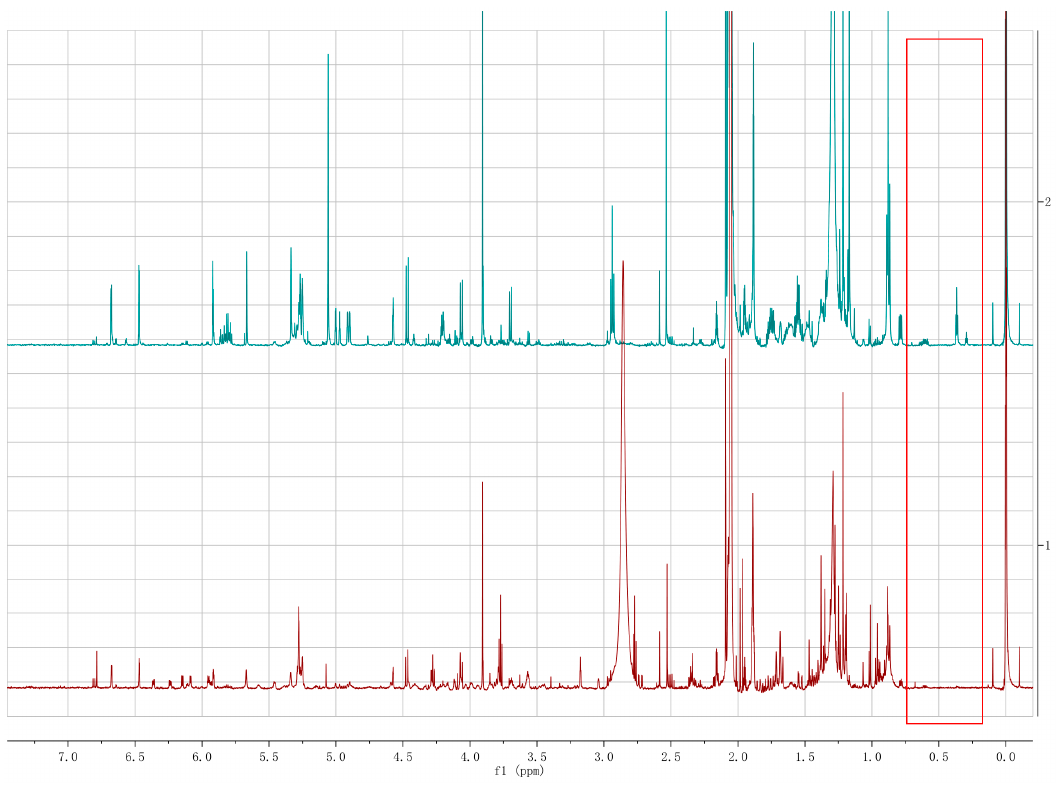
Figure 2. 1 H NMR spectra of the WT (brown) and MeHatOE (dark green), respectively (600 MHz, Acetone- d 6 ).